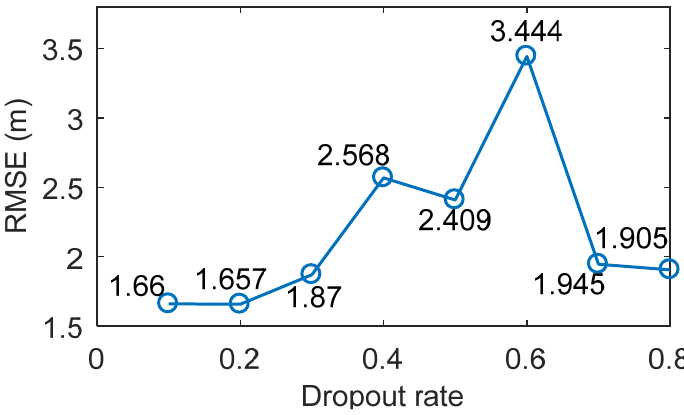
Figure 12. Nowcasting accuracy including p -values.